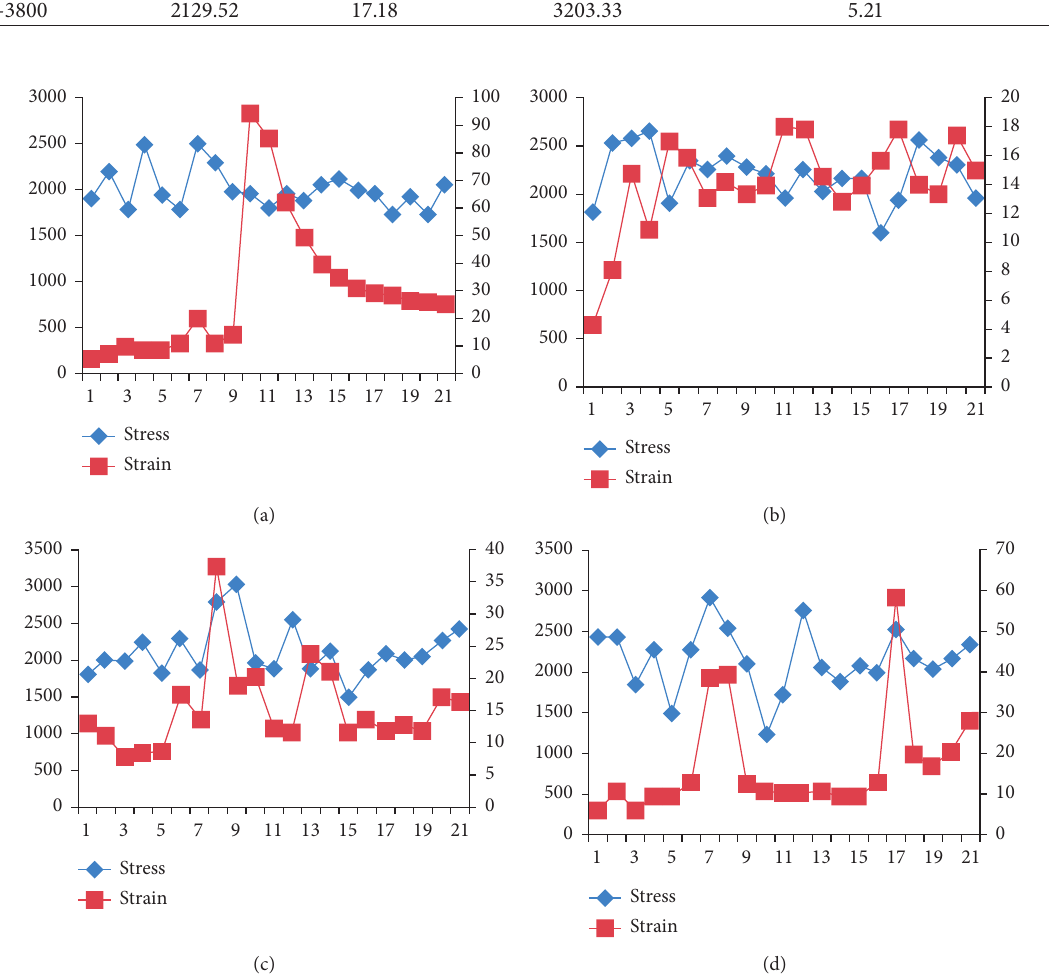
Figure 11: Stress strain curves for cutting conditions of speed 2500, 3800rpm, High Speed Steel (HSS), and tungsten carbide (WC) end milling cutters with heat treated and nonheat treated